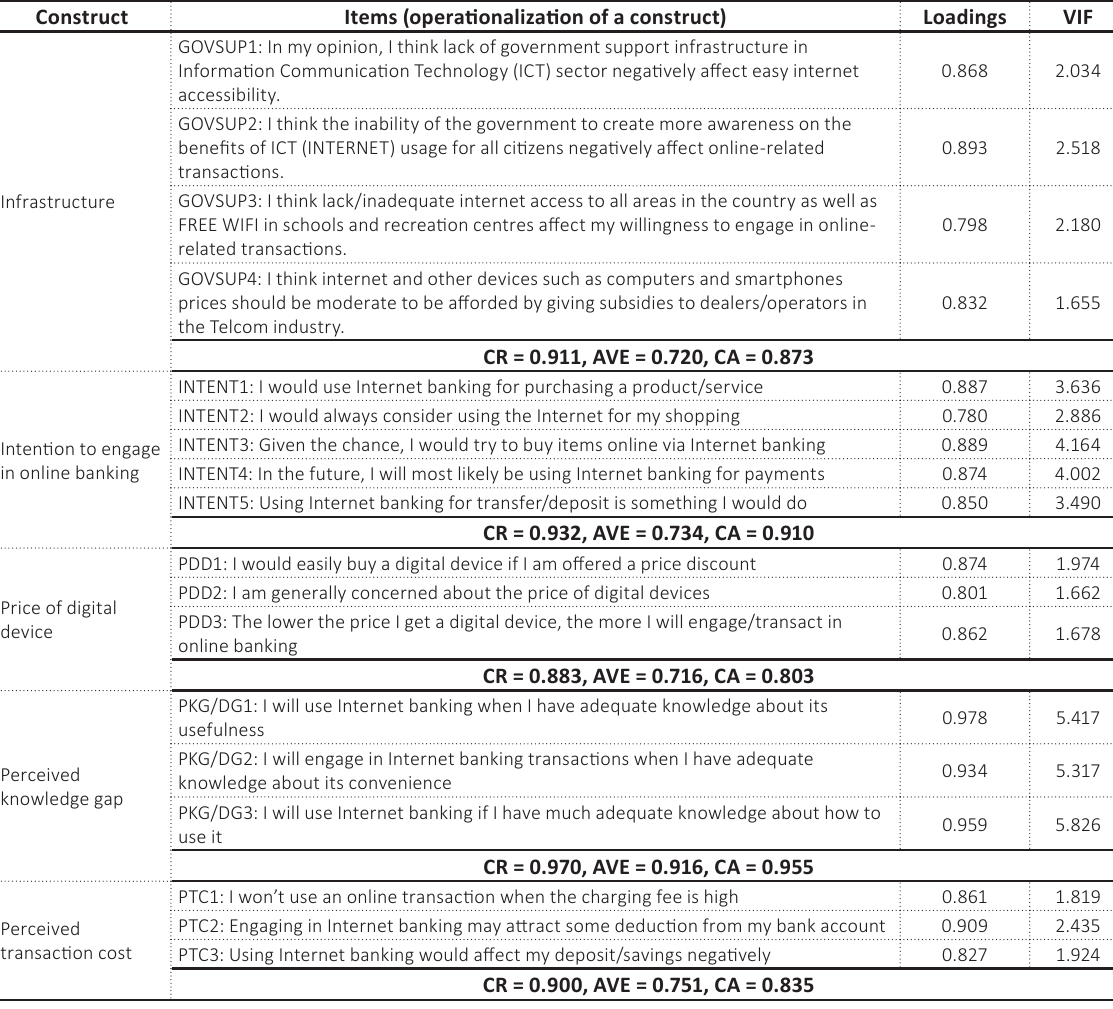
Table 2. Cross-loadings and construct reliability and